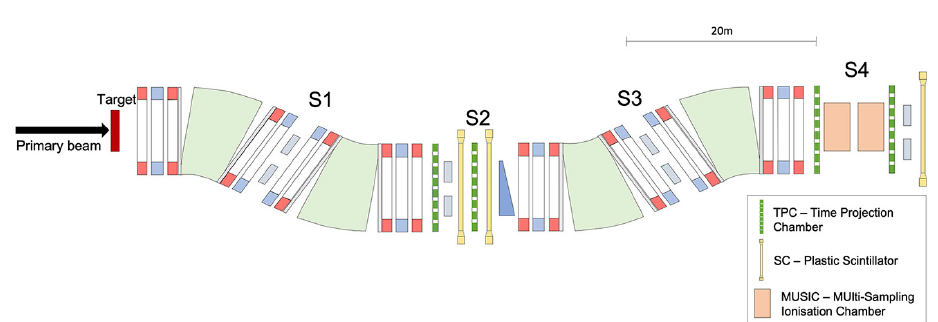
Fig. 2. – Schematic of the FRS magnetic spectrometer: the main detectors for ion identification are labeled in the box on the